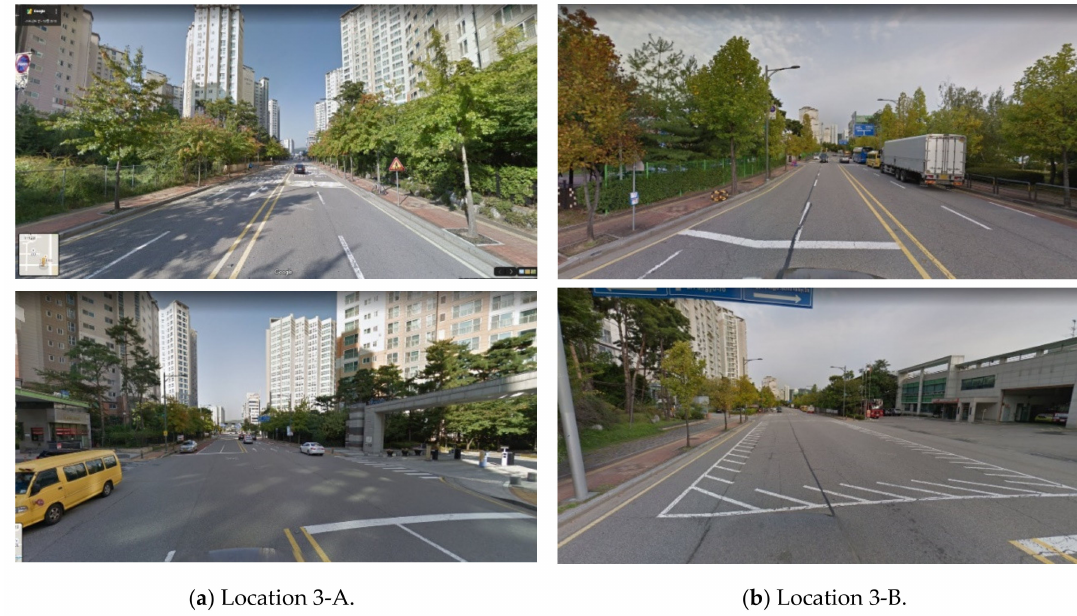
Figure 15. Sudden VPD changes as open space appears (Naver Maps